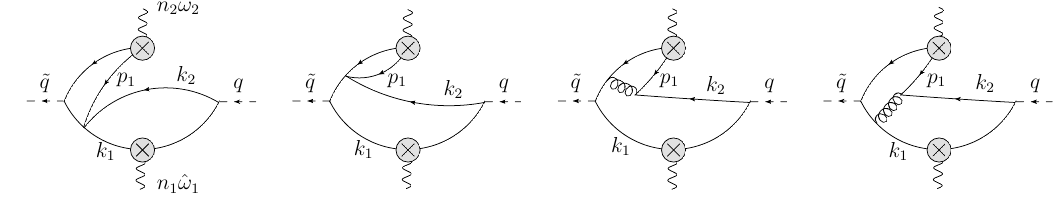
Figure 3 . Creation of particles by the scalar detector O J =0 (ˆ ω 2 , n 2 ) .